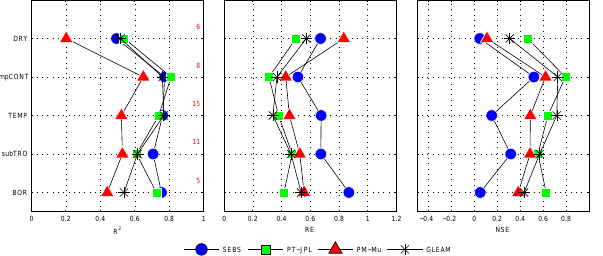
Figure 8. Coefficient of determination ( R 2 ), relative error (RE) and Nash–Sutcliffe efficiency (NSE) for model simulated results across the five different climate zones ( y axis). The zones are represented by dryland (DRY), temperate continental (TempCONT), temper- ate (TEMP), sub-tropical (subTRO) and boreal (BOR). Each point represents the collection of all towers located within the selected climate zone, with the number of towers shown on the secondary y axis of the R 2 panel in red.